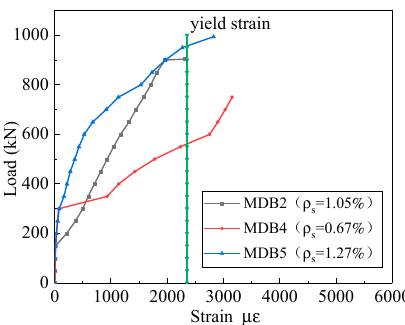
Figure 15. Relation curve between ρ s and horizontal distributing reinforcement strain.